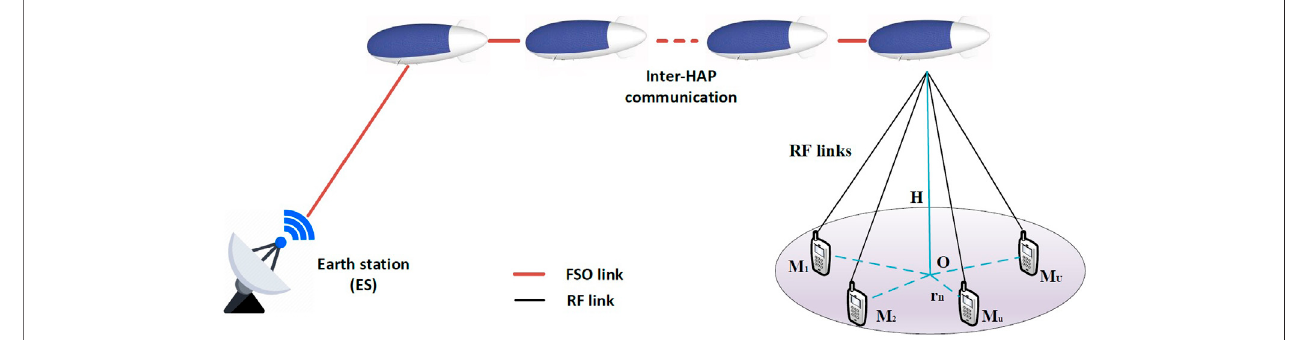
FIGURE 1 | Considered system